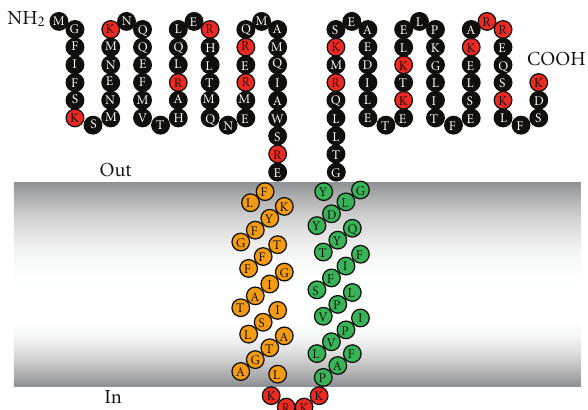
Figure 2: Structural model of Plg-R KT . Green indicates amino acids within the predicted primary transmembrane helix. Orange indicates amino acids within the predicted secondary transmembrane helix. Red indicates basic amino acids. This research was originally published in [18].